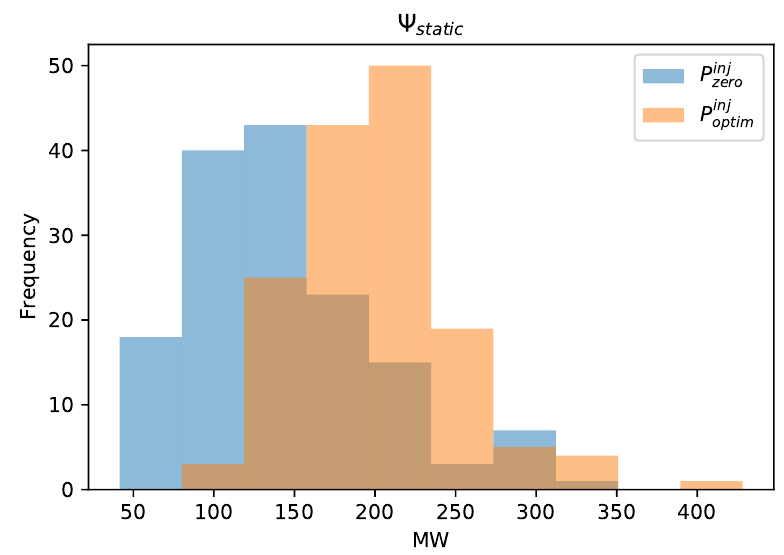
Figure 2. Error distribution for the static PTDF matrix representation when applying the P inj zero and P inj datasets. optim